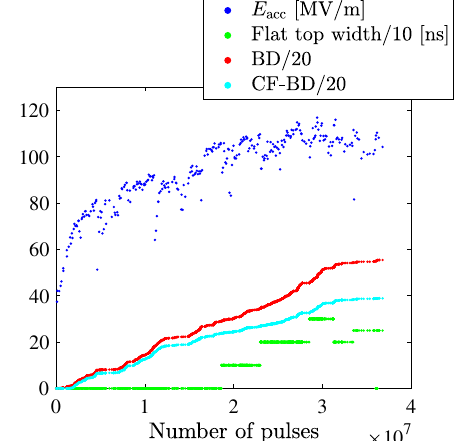
FIG. 17. Summary of the conditioning history of THU-CHK- #3. The blue dots denote E [MV/m], the green dots denote flat acc top pulse width [ns] divided by 10, the red dots denote total breakdown number divided by 20, and the cyan dots denote number of CF-BDs divided by 20.